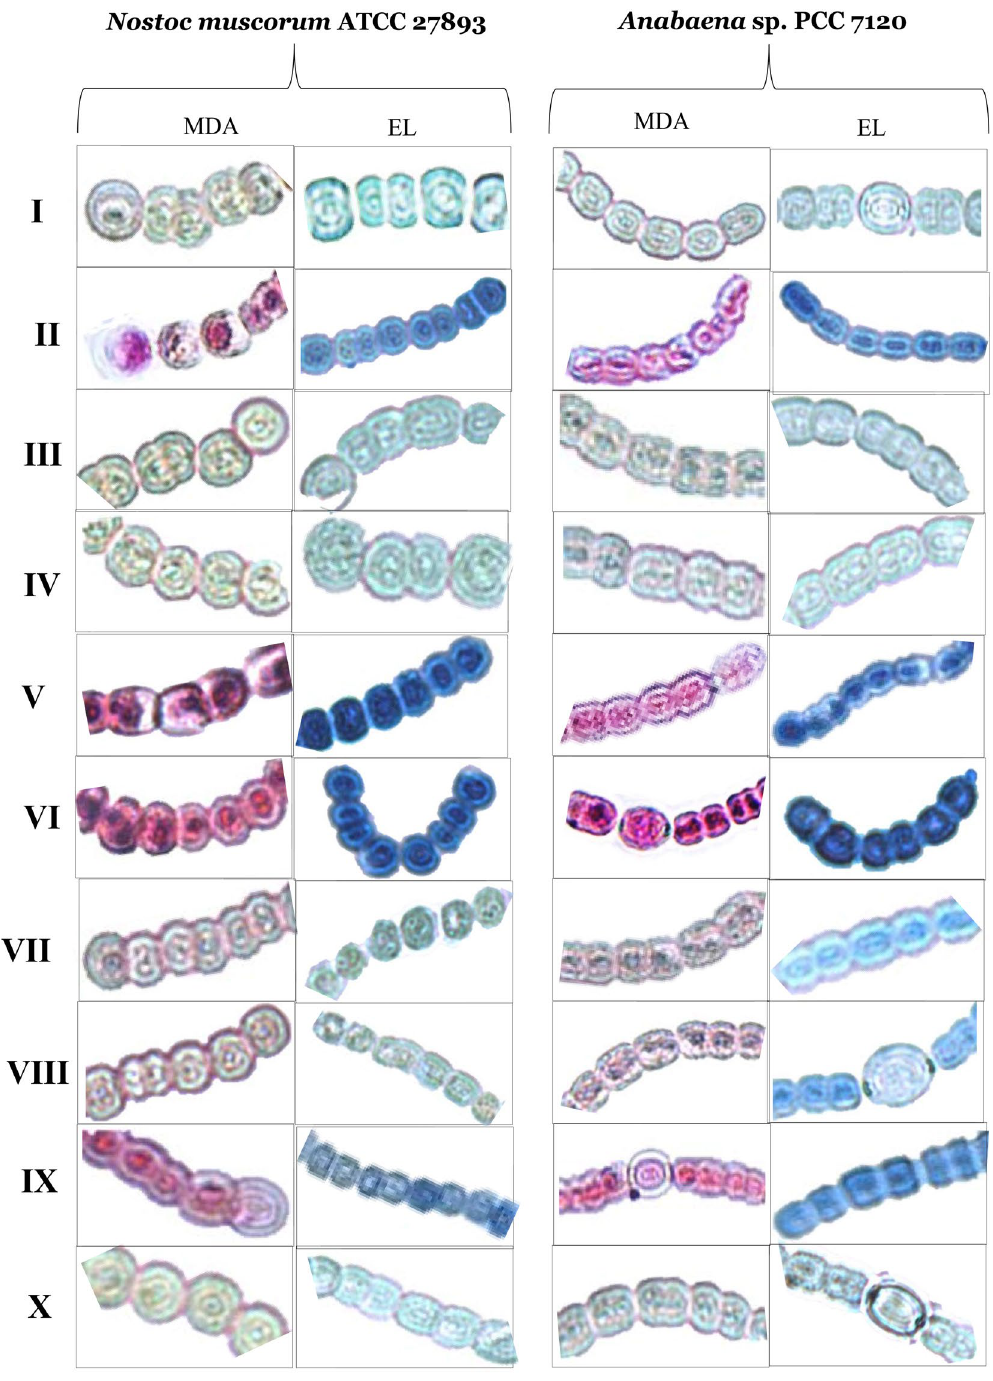
Figure 4. In vivo visualization of MDA; pink staining and EL; sky blue staining inside the cells of Cd stressed Nostoc muscorum ATCC 27893 and Anabaena sp. PCC 7120 when treated with H 2 O 2 and NO (SNP). Where lane I: Control, lane II: Cd, lane III: Cd + H 2 O 2 , lane IV: Cd + SNP, lane V: Cd + H 2 O 2 + PTIO, lane VI: Cd +